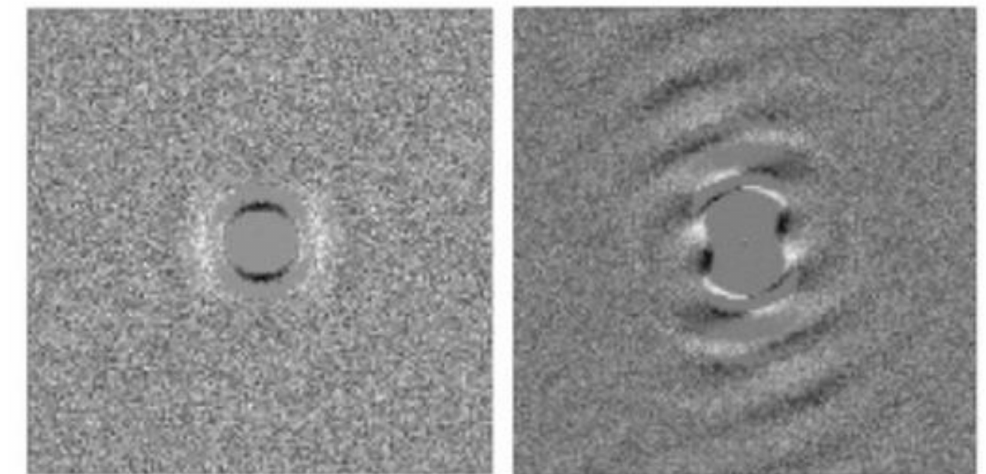
Figure 5. Scattering patterns calculated using Monte Carlo simulations for an idealized monodisperse ferrofluid at rest and experiencing a shear rate of 1 s − 1 with a magnetic field strength of 200 mT applied for two di ff erent directions between a neutron beam and a magnetic field. The images were kindly provided by Patrick Ilg (University of Reading) and were obtained using the methods given in